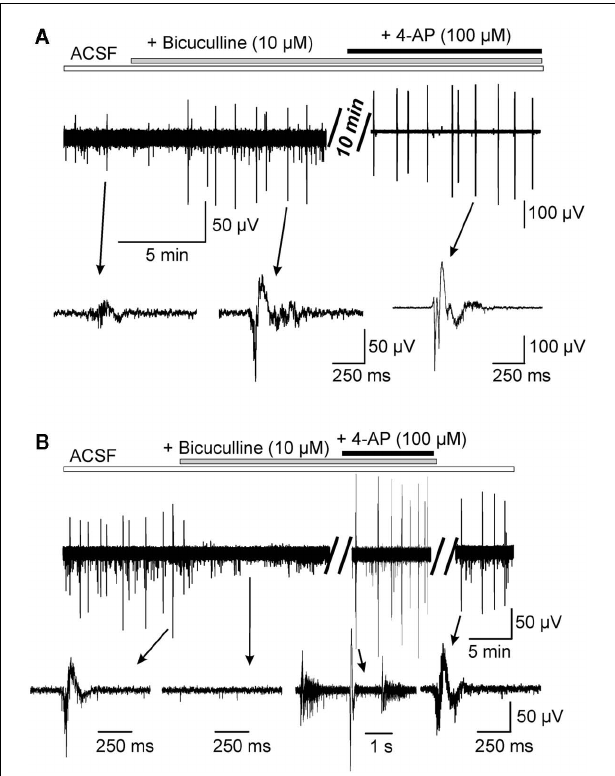
FIGURE 2 | Differential effects of the bicuculline on the spontaneous network activity in Kcc2 + / + (A) and Kcc2 − / − (B) acute hippocampi. Field potential recordings from the CA3 region of E18.5 hippocampi. Notice that in Kcc2 + / + hippocampi the application of the bicuculline produced transient inhibition of spontaneous GDPs, whereas in Kcc2 − / − hippocampi it produced long-lasting inhibition of spontaneous epileptiform activity.